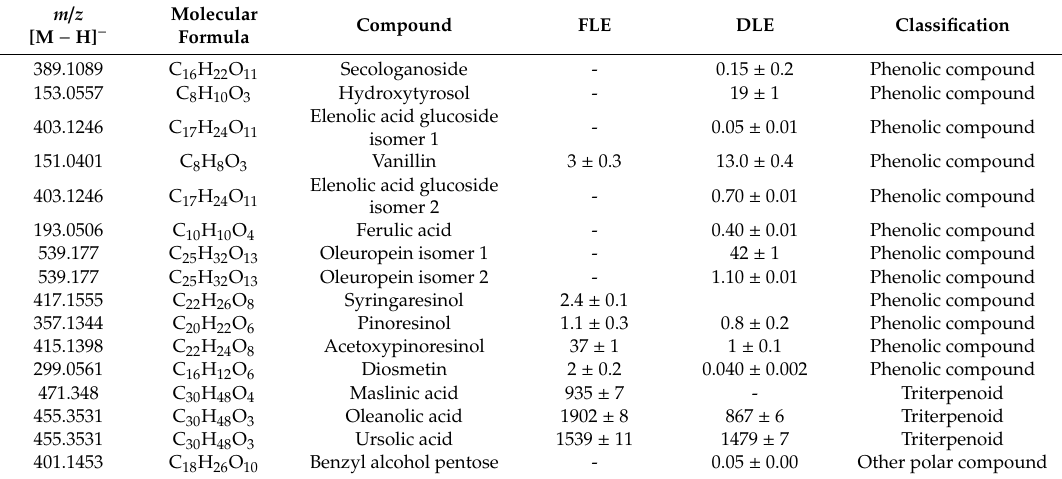
Table 1. Identified and quantified phytochemicals in the SC-CO 2 olive leaf extracts. m / z [M − H]